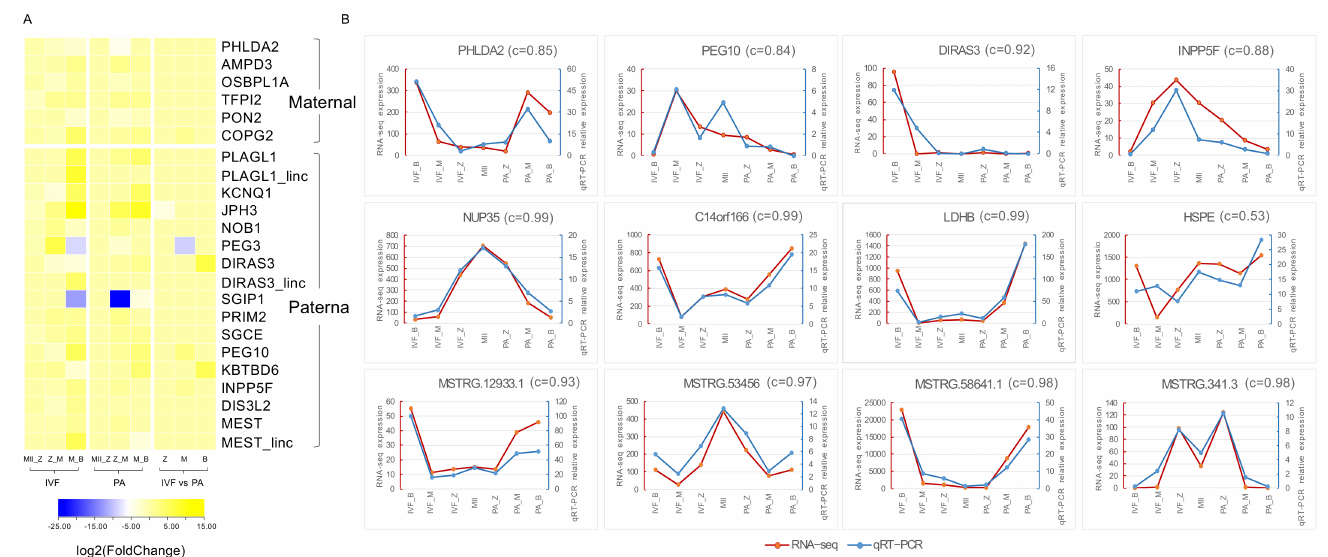
Figure 5. Differential expression analysis of imprinted genes and qRT-PCR validation of RNA-seq. ( A ) Heat map of DE imprinted genes. ( B ) qRT-PCR analysis of randomly selected imprinted genes, protein-coding genes, and lincRNAs. Red line represents average expression of RNA-seq; blue line represents average expression of qRT-PCR, and C value is the correlation between RNA-seq and